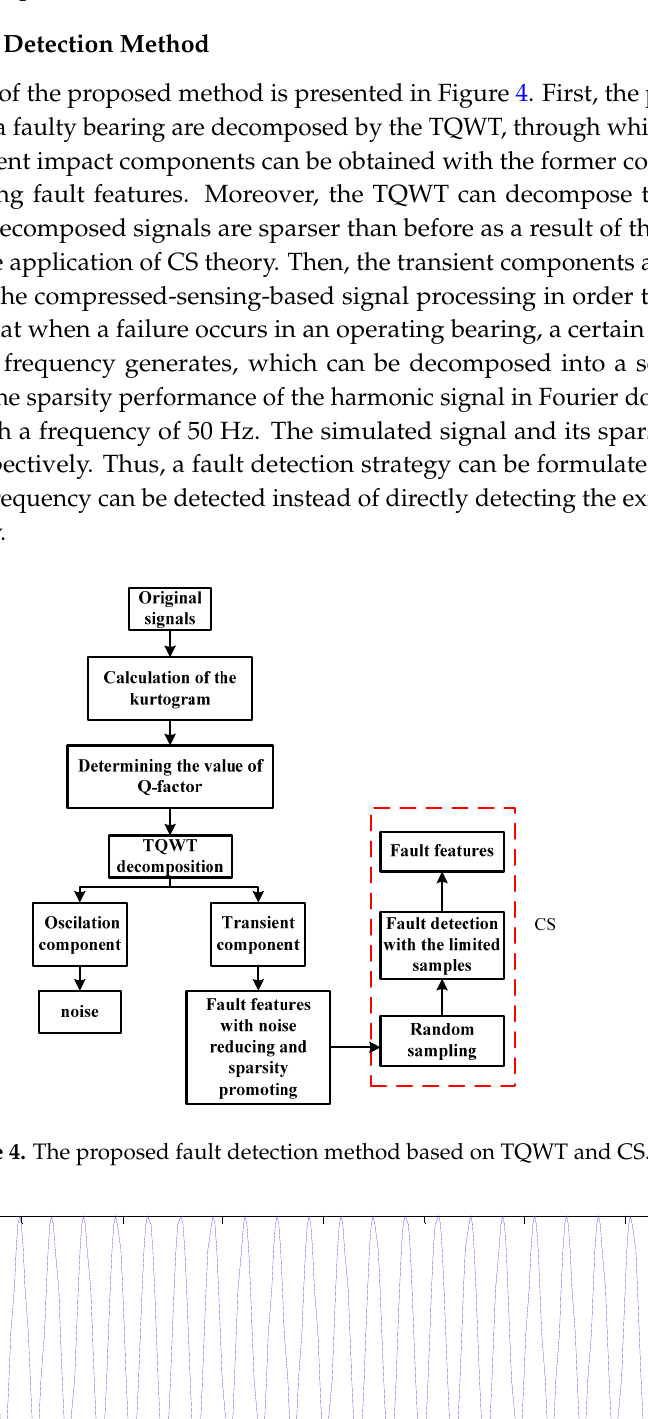
Figure 6. The sparsity of the harmonic signal in the Fourier domain. Before performing TQWT, two Q-factor values should be determined. Since the kurtogram can represent the bandwidth and the center frequency of a signal, it is employed to calculate the high Q-factor. The low Q-factor is artificially set to be 1.5 by experience. When performing the TQWT to the original signals, the decomposed transient impact signals will be sparser with noise reduced, which makes it easier to detect the harmonic signal of interest. To meet the requirement of RIP principle, Gaussian random matrix is selected as measurement matrix for dimension reduction, which has low correlation with the Fourier basis [39,42,45]. The elements in Gaussian random matrix